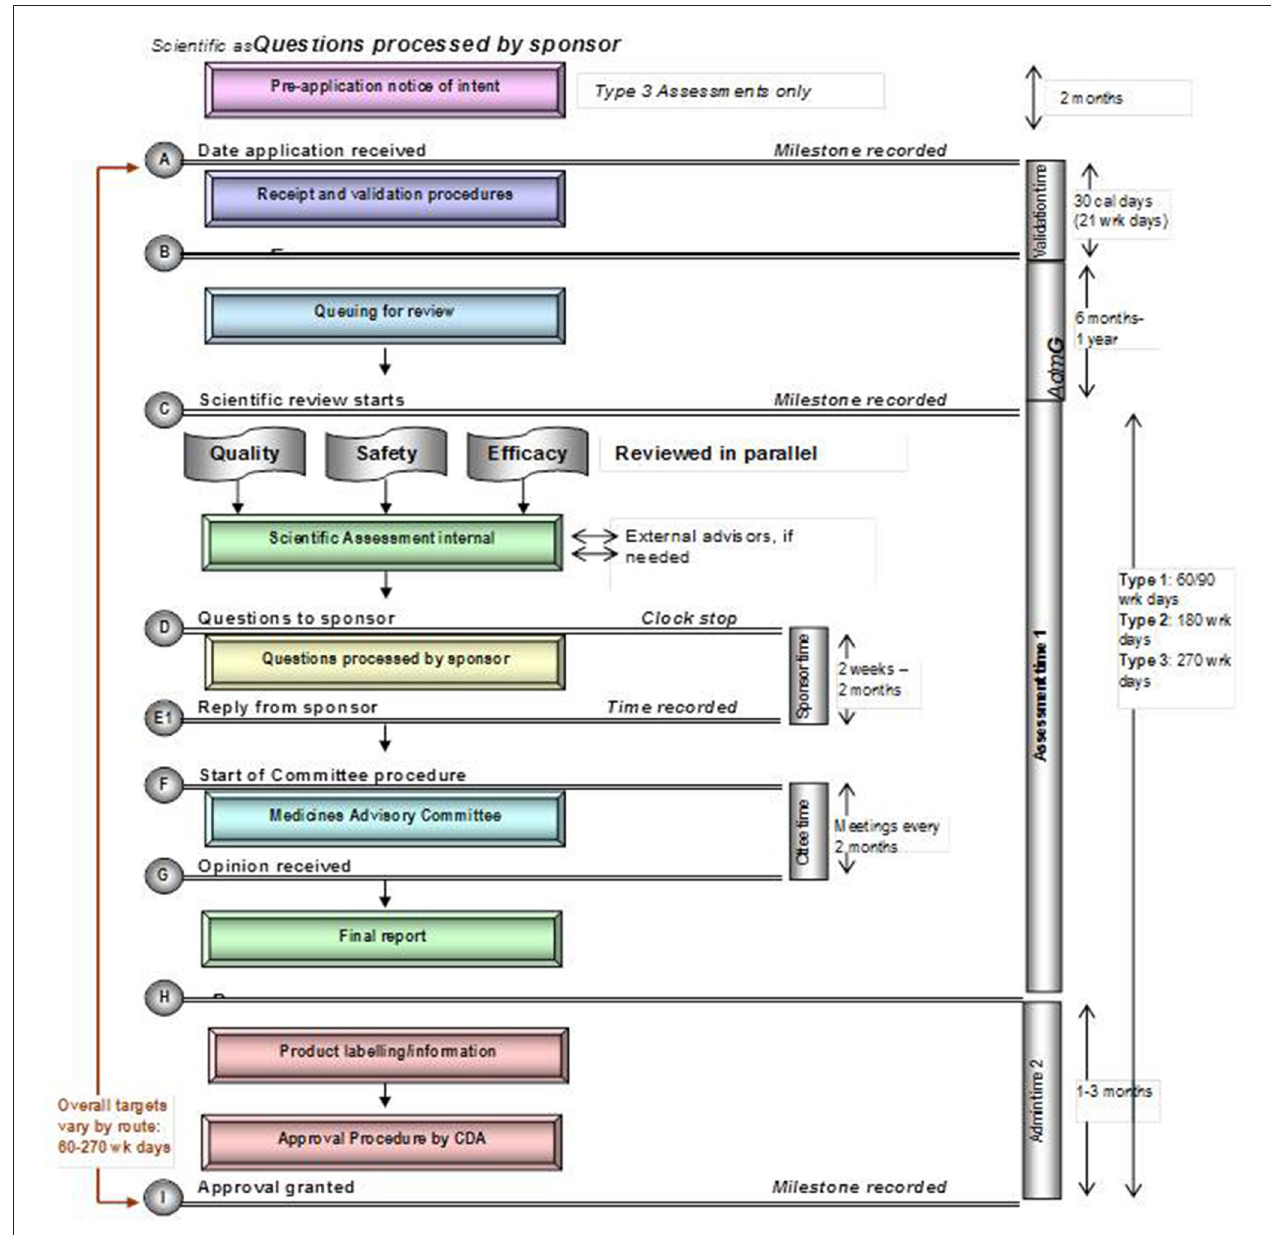
FIGURE 5 | Registration process map for